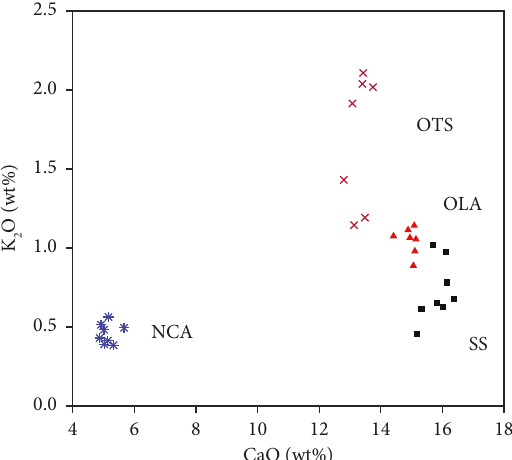
Figure 12: A plot of CaO against K 2 O of SS, OTS, OLA, and NCA